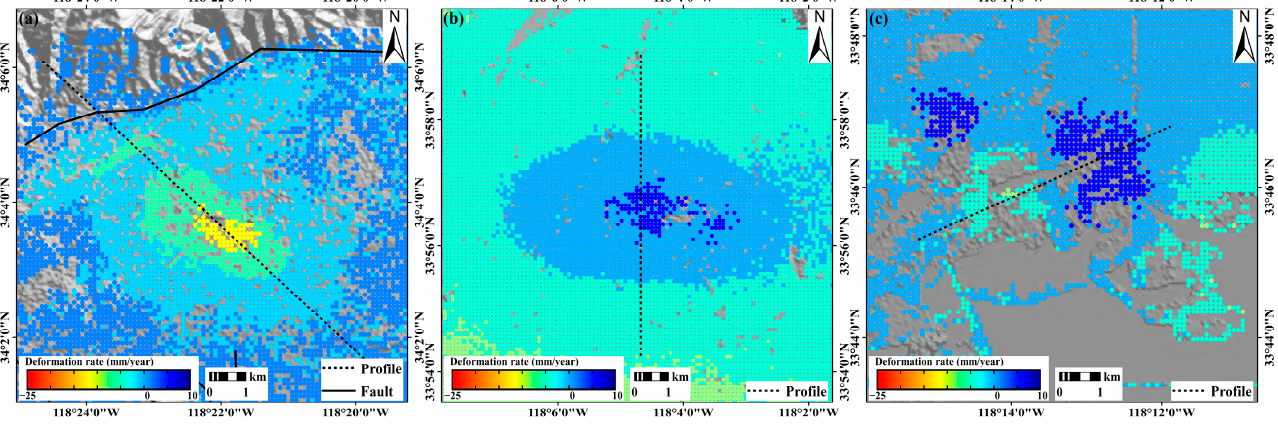
Figure 11. Deformation field of ( a ) Inglewood oilfield; ( b ) Santa Fe Springs oilfield; and ( c ) Wilming- ton oilfield. ( d – f ): the corresponding deformation rate extracted along the profile. From the GPS and InSAR observation data monitored by BKMS near the Santa Fe Springs oilfield, the linear deformation trend around the oilfield is not obvious but mainly characterized by periodic fluctuations. The subsidence and uplift in this area are directly related to the extraction and reinjection of underground materials (oil, gas, etc.) [18] 4.3. Validation with GPS Observation Data From Figure 5, we can see that SCIGN has densely distributed GPS stations, but its spatial resolution is still very low compared with InSAR measurement points. We ob- tained observation data from 49 GPS monitoring stations, and 25 stations (except that no effective InSAR measurement points are identified around some GPS stations) are utilized for mutual verification with InSAR results (as shown in Figure 12). The GPS three-dimen- sional (3-D) deformation is projected in the LOS direction of InSAR. The comparison with GPS monitoring data shows that the deformation measurement accurately reflects the sur- face deformation fluctuation, and the periodicity is consistent. -40-200204060 D e f o r m a t i o n ( mm )